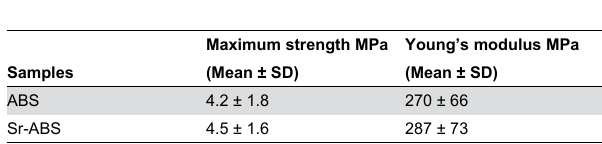
Table 1. Compressive strength and Young’s modulus of the